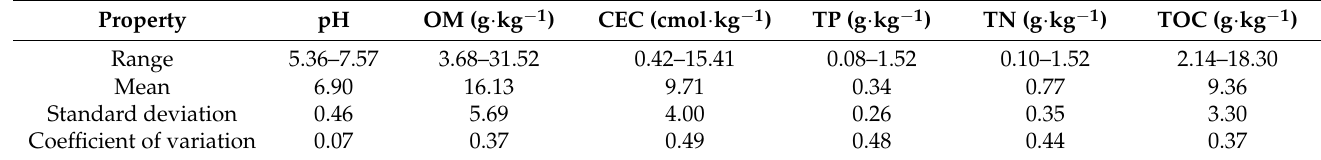
Table 5. Descriptive statistics of physicochemical properties of surface soils in Laizhou.